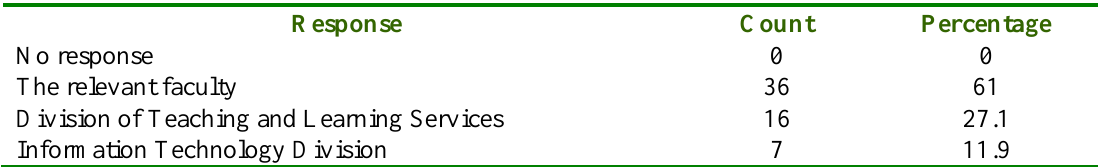
Table 5. Organizational Units Responsible for the Quality of